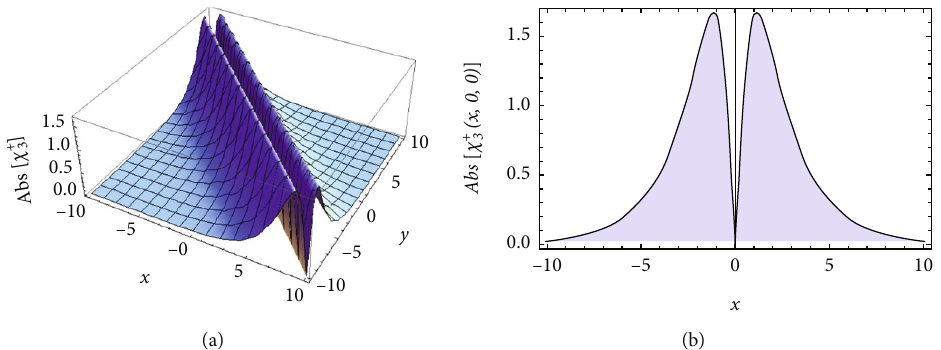
x , y , t Þj with the parameters λ = 1 , v = 1 , v 3 ð